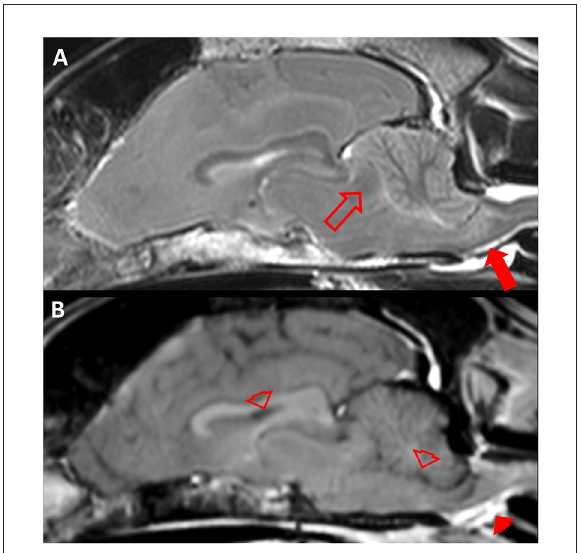
FIGURE4 Magnetic resonance imaging (MRI) of a 10.75 year old Australian Shepherd (case 3). (A) Sagittal T2 weighted (w) MRI of the brain. Note the caudal cerebral herniation (empty arrow) which causes concave distortion of the rostral cerebellum and secondary transforaminal cerebellar herniation with compression of the brainstem and an intramedullary hyperintense lesion (filled arrow). (B) Sagittal T1w MRI approximately 3min after intravenous contrast medium application. Note that there is physiological intravenous contrast enhancement extracranially (e.g., filled arrowhead) but no contrast medium is visible in structures which physiologically take up contrast medium (empty